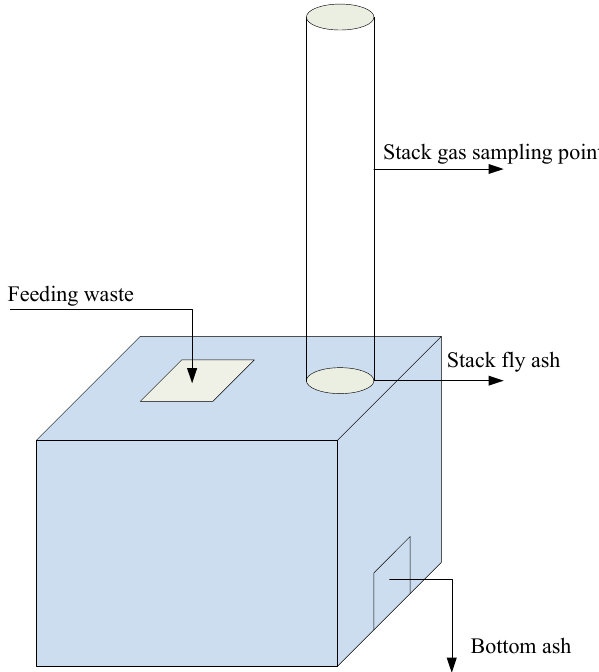
Figure 1. Flow sheet and sampling site of the analyzed small-scale waste incinerator (SWI) in the absence of air pollution controls (APCs).